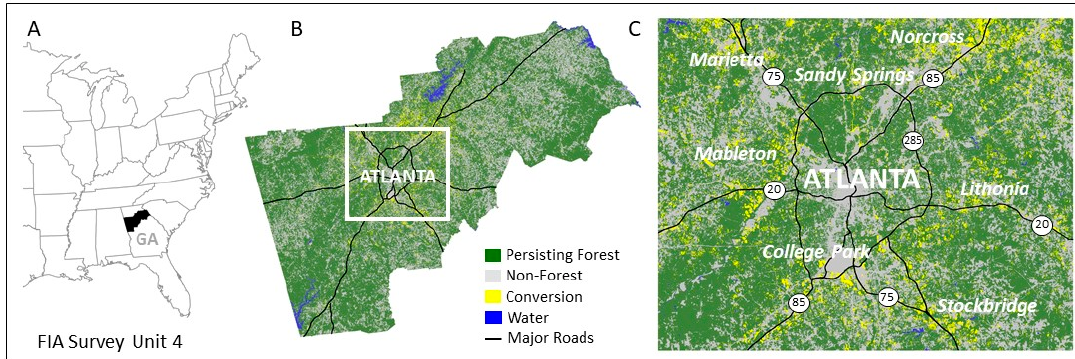
Figure 1. Study area consisting of the Forest Inventory and Analysis survey unit 4 in north central Georgia, USA (black shading, Panel A ) surrounding the greater Atlanta metropolitan area (Panel B ). The land classification maps shown in Panels B and C identify areas of persisting forest (green) and potential forest conversion (yellow) occurring between 1987 and 2010 (adapted from [25]). Developed from Landsat time series, the maps estimate that nearly 75,000 ha of forest were converted from forest to other land uses during the 23-year period of study. Much of the conversion is concentrated along major roadways, as seen in Panel C .